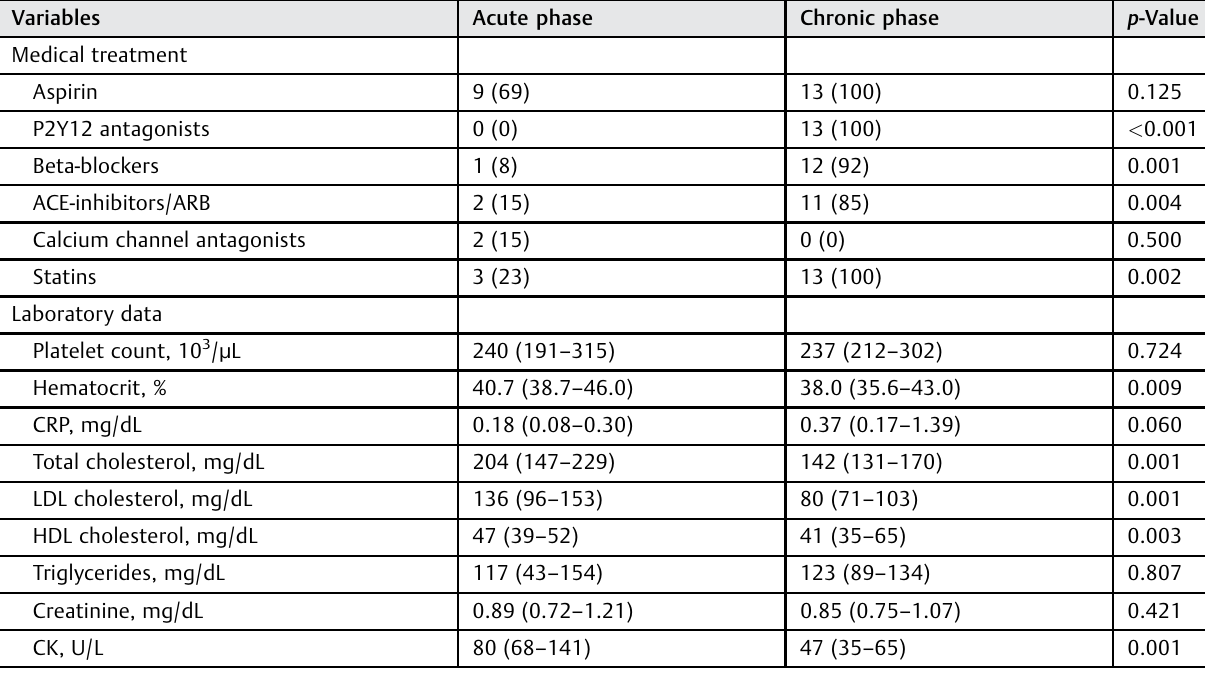
Table 3 Baseline characteristics of patients with acute MI in the acute or chronic phase Variables